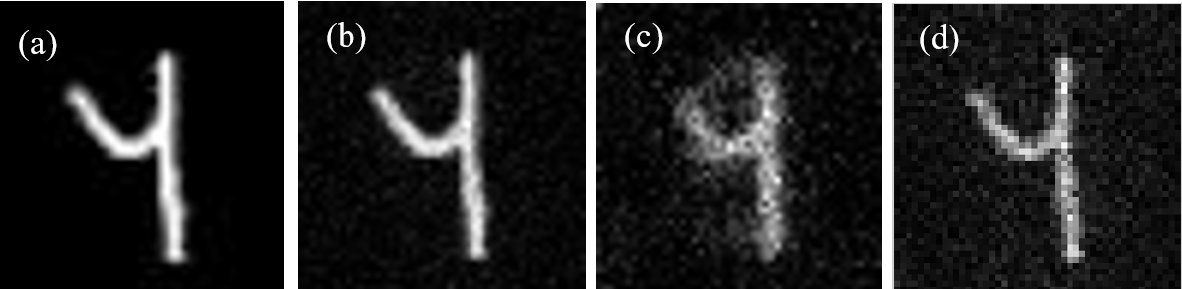
Figure 9. Comparison of reproduction results. ( a ) Original image; ( b ) MLCNN reconstruction; ( c ) U-net reconstruction; and ( d ) GS algorithm reconstruction.